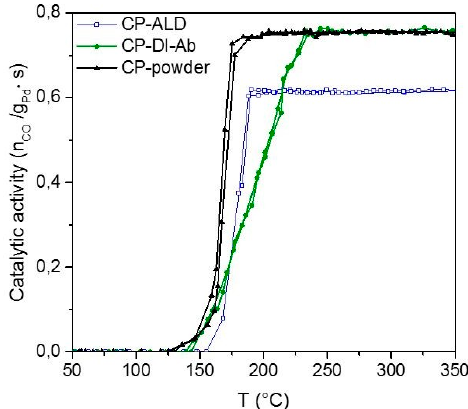
Figure 6. Catalytic activities in CO oxidation of CP-ALD as eggshell catalyst, CP-DI-Ab as homogeneous catalyst, and its corresponding powder. Rise and descent from room temperature to 350°C.